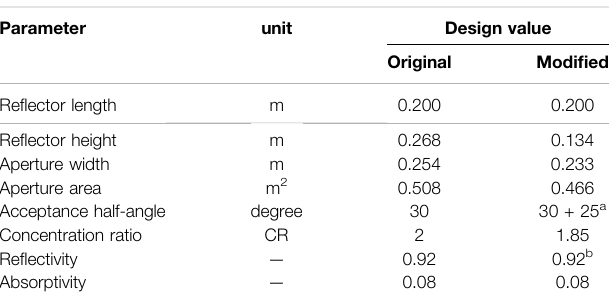
TABLE 2 | Speci fi cations of the developed modi fi ed compound parabolic